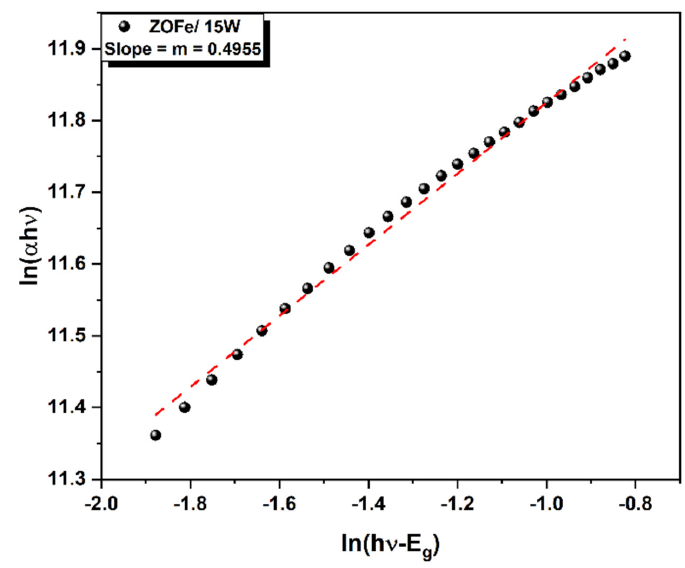
Figure 12. Type of the optical transition used in the undoped and Fe doped ZO thin